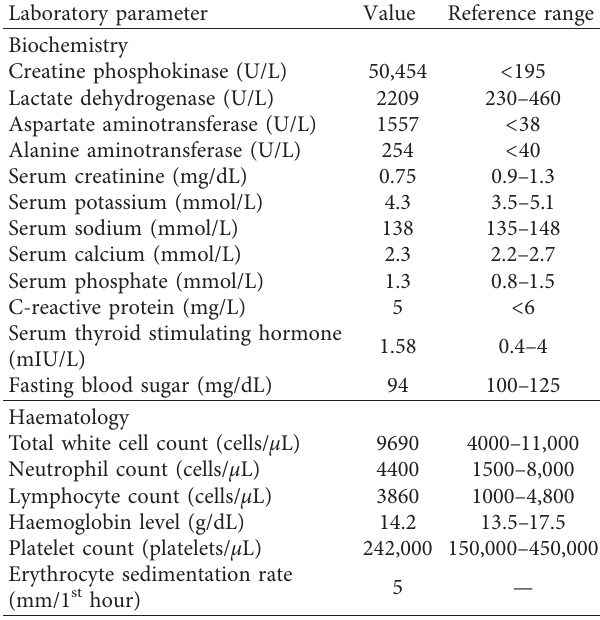
Table 1: Biochemical and haematological parameters of the